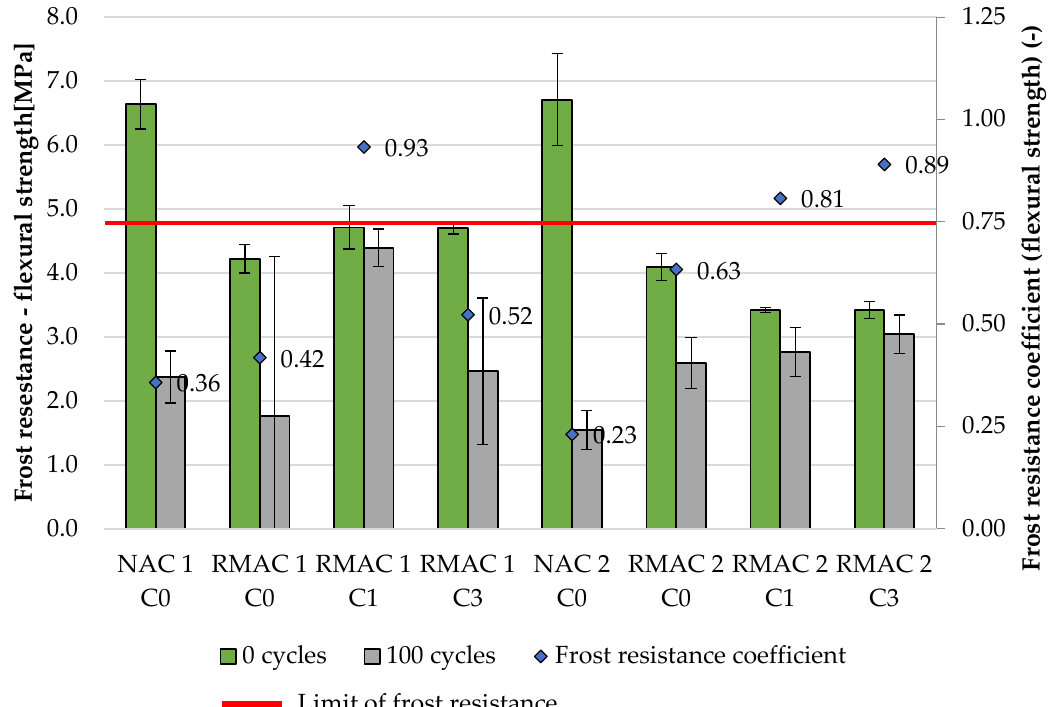
Figure 6. Flexural strength for 28 days (before freezing), after 100 freeze-thaw cycles and frost resistance coefficient determined from flexural strength.